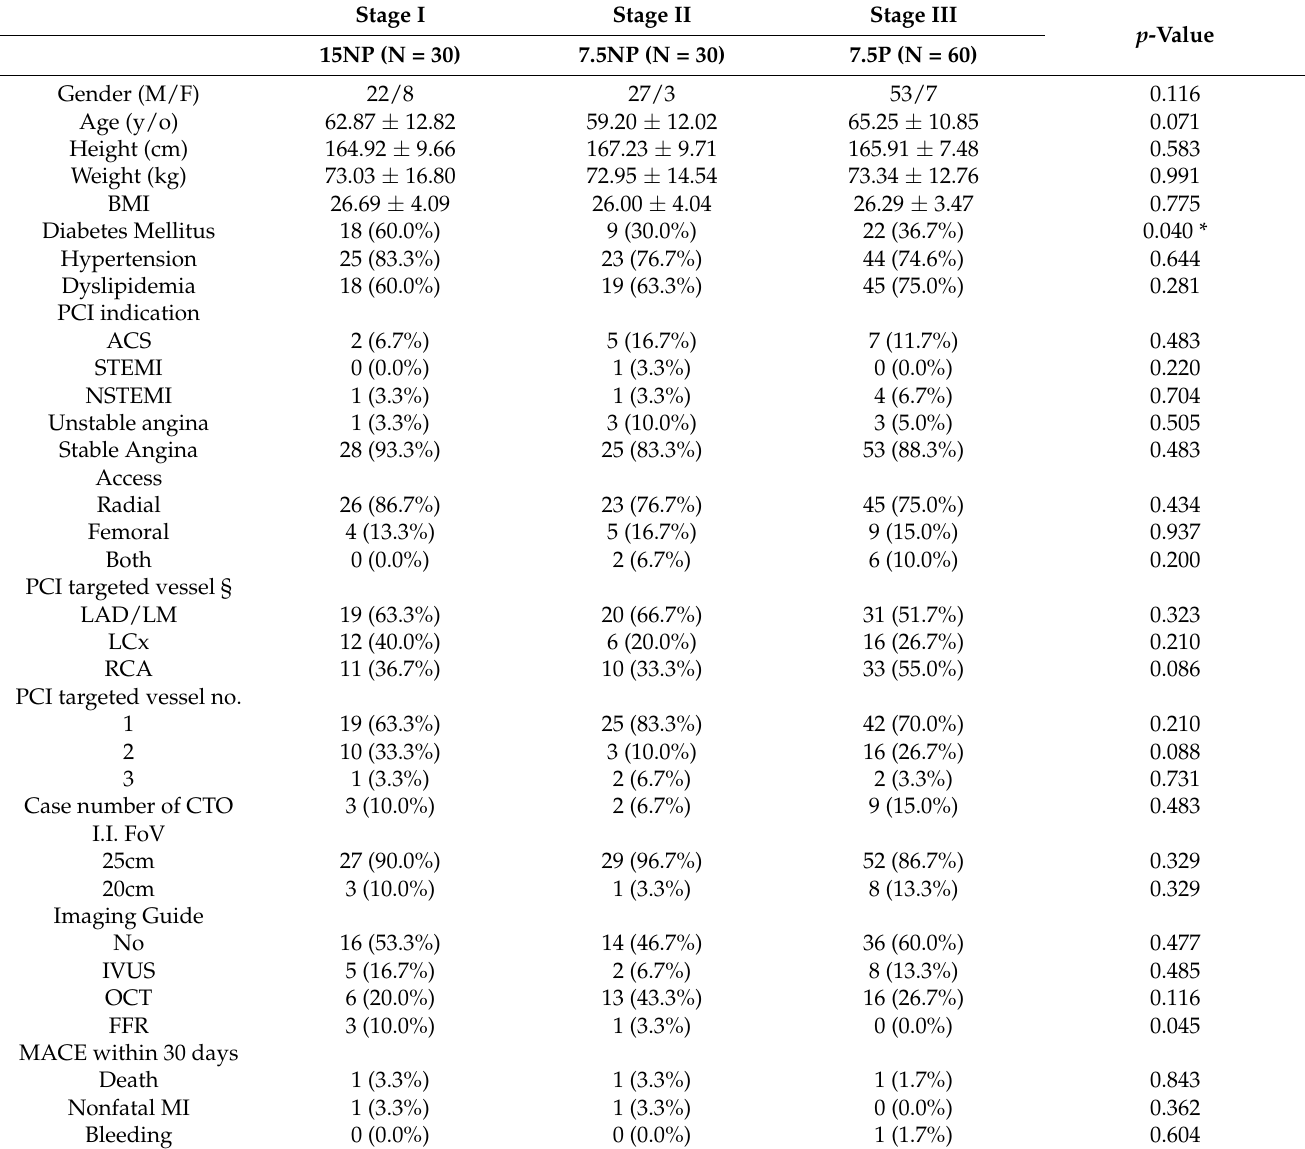
Table 1. Basic characteristics of patients at different